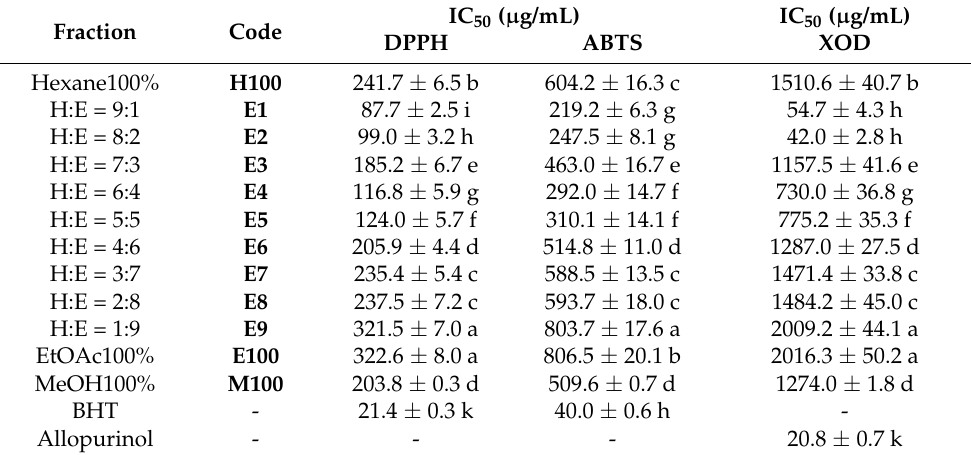
Table 1. Antioxidant activities measured by DPPH, ABTS and XOD of EtOAc extract fractions from M. oleifera twigs in term of IC 50